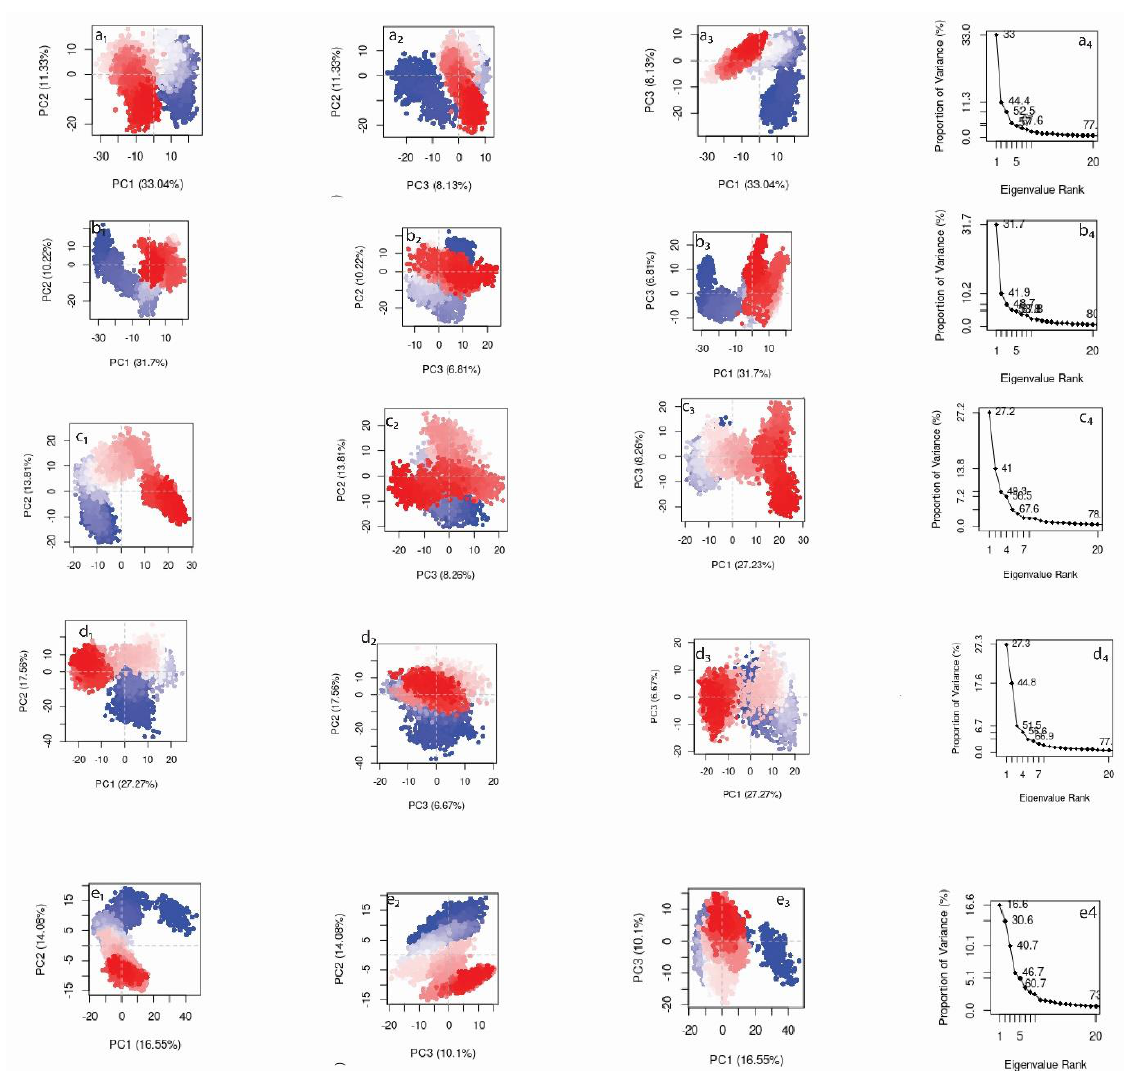
Figure 6. Principal component analysis (PCA) for the top three principal components obtained by dimensionality reduction of the motion observed in the 100 ns MD